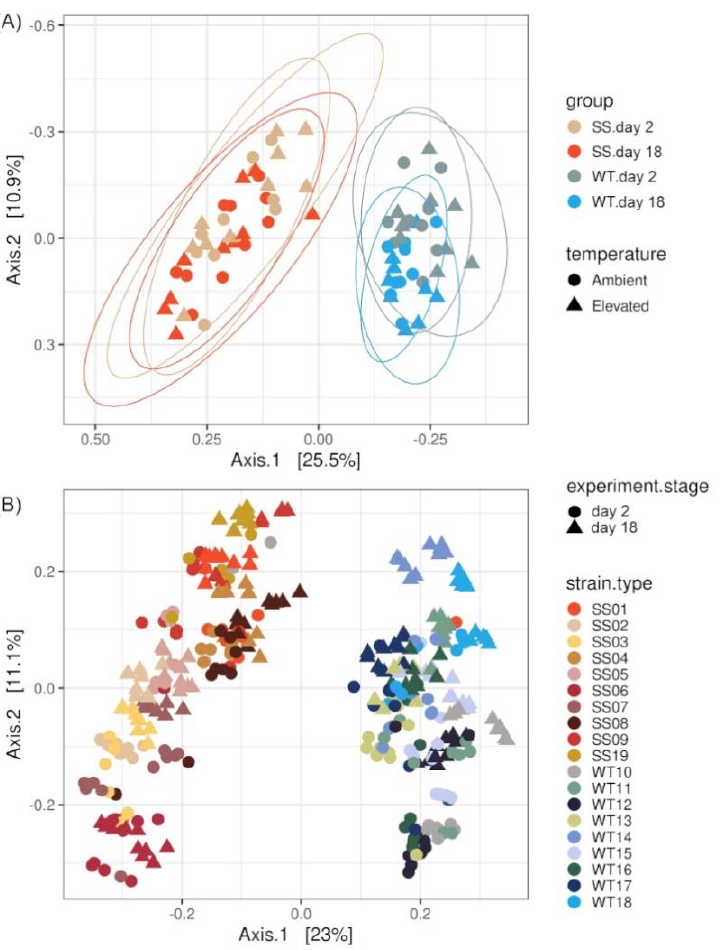
Figure 3. PCoA visualization using the Bray–Curtis dissimilarity separating samples by ( A ) their strain group (SS or WT) based on a reduced dataset with average values across strains. Data are shown for day 2 and day 18. The SS and the WT strains had different overall bacterial community composition. ( B ) The individual Cladocopium C1 acro strains are shown based on the full dataset and each SS and WT strain had a distinctive bacterial community fingerprint.